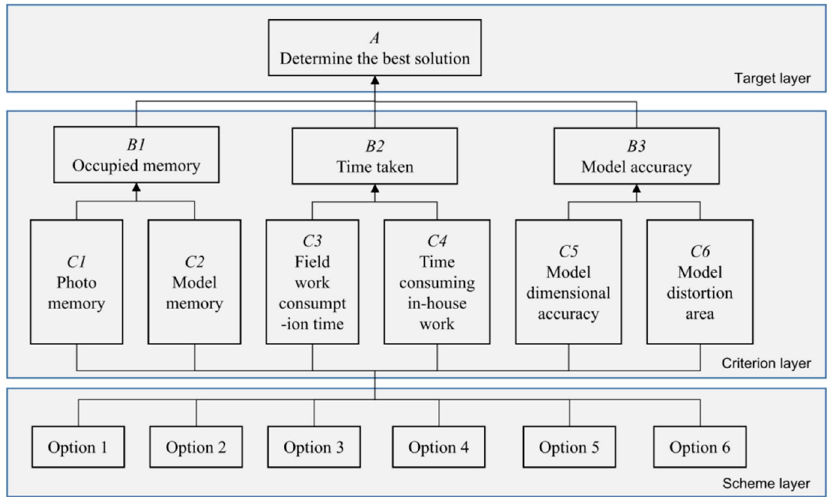
Figure 1. AHP structure model.